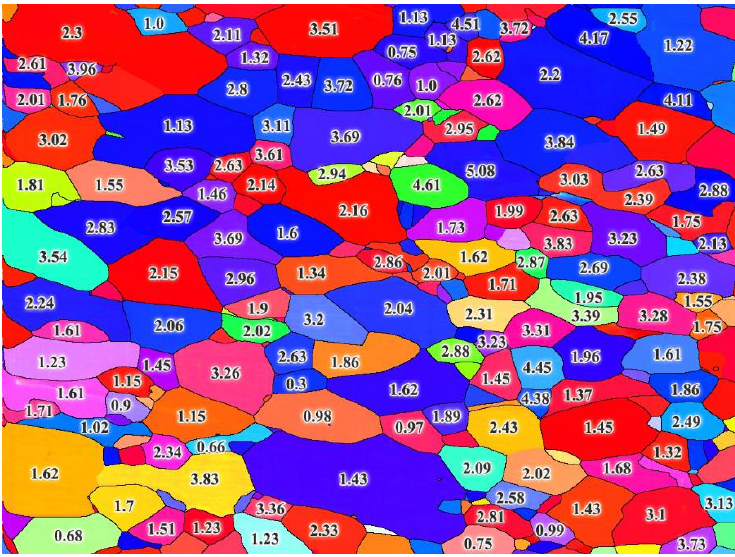
Figure 5. The orientation rotation degrees for grains caused by compression.